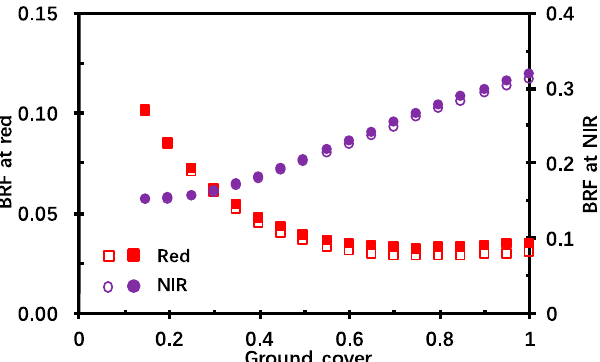
Figure 7. Bidirectional reflectance factor ( BRF ) at red and NIR bands in the nadir view direction as a function of ground cover. Solid symbols correspond to the canopy BRF when leaf specular reflection is accounted for, whereas hollow symbols denote that when leaves are bi-Lambertian scatters. Canopy LAI is constant and equals 7.0. Plant LAI varies with ground cover as 7/gc. Albedo of the canopy background is 0.18 at both red and NIR bands. SZA and SAA are 30° and 0° , respectively.